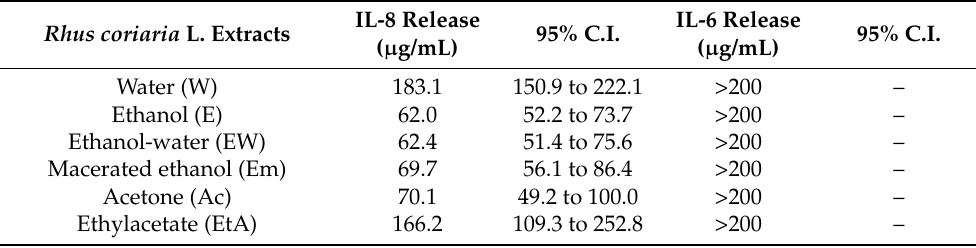
Figure 3. Effects of Rhus coriaria L. extracts (( A ) 100% water (W), ( B ) 100% ethanol (E), ( C ) ethanol– water (ethanol:water 50:50 v / v , EW), ( D ) ethanol macerated (plant material subjected to maceration with pure ethanol for 48 h, Em), ( E ) acetone (Ac), ( F ) ethylacetate (EtA)) on the H. pylori -infected GES-1 cells (6 h). The cells were treated with H. pylori :cell ratio 50:1. The release of IL-8 was assessed through an ELISA assay. The reference compound (black color) used was EGCG 50 µ M ( − 39%). Data are reported as percentage in comparison to the stimulated control, which was arbitrarily assigned to 100% value. * p < 0.05, ** p < 0.01, *** p < 0.001 versus H. pylori . H. pylori , Helicobacter pylori . Table 3. Summary of IC 50 s ( µ g/mL) of Rhus coriaria L. extracts on IL-8 and IL-6 secretion induced by H. pylori in GES-1